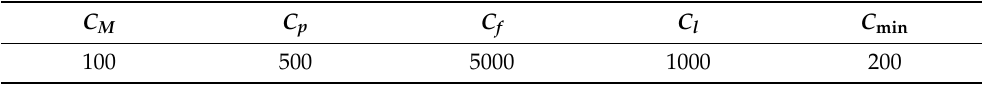
Table 2. Same parameter values of different